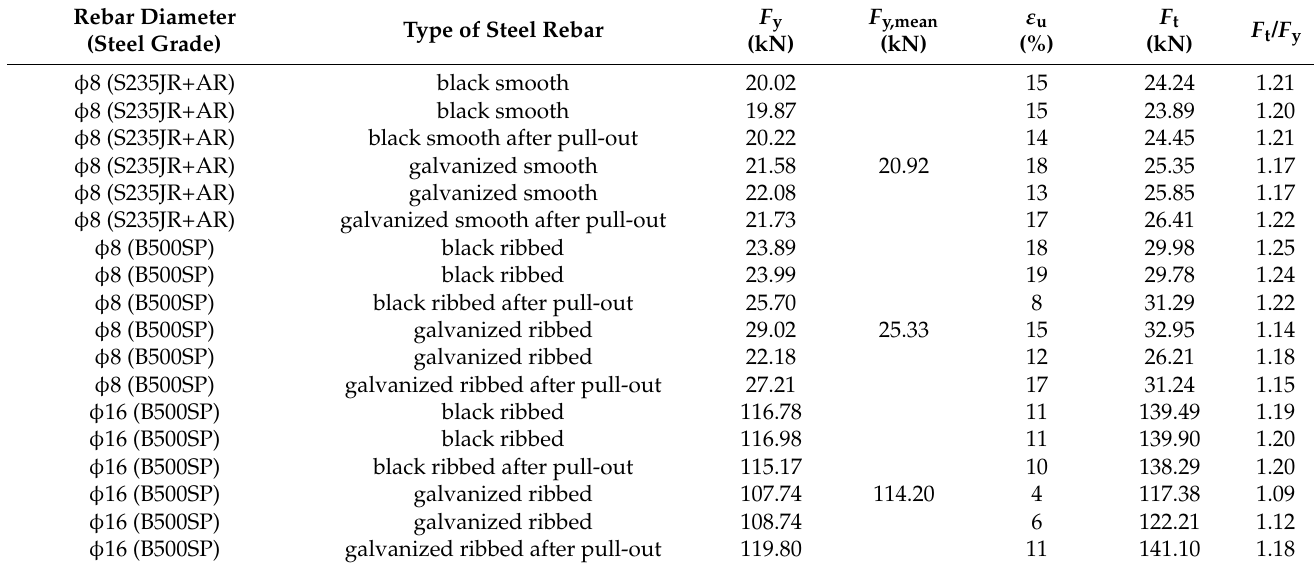
Table A2. Strength characteristic for all types of the test rebars used in the tests, determined from the graphs of “stress σ –strain ε ” illustrated in Figure 2: F y —the force corresponding to yield strength of steel f y , F y,mean —the force corresponding to yield strength of steel f y averaged from six values ε u —steel strains at the maximum force, F t —the force corresponding to tensile strength of steel f t.